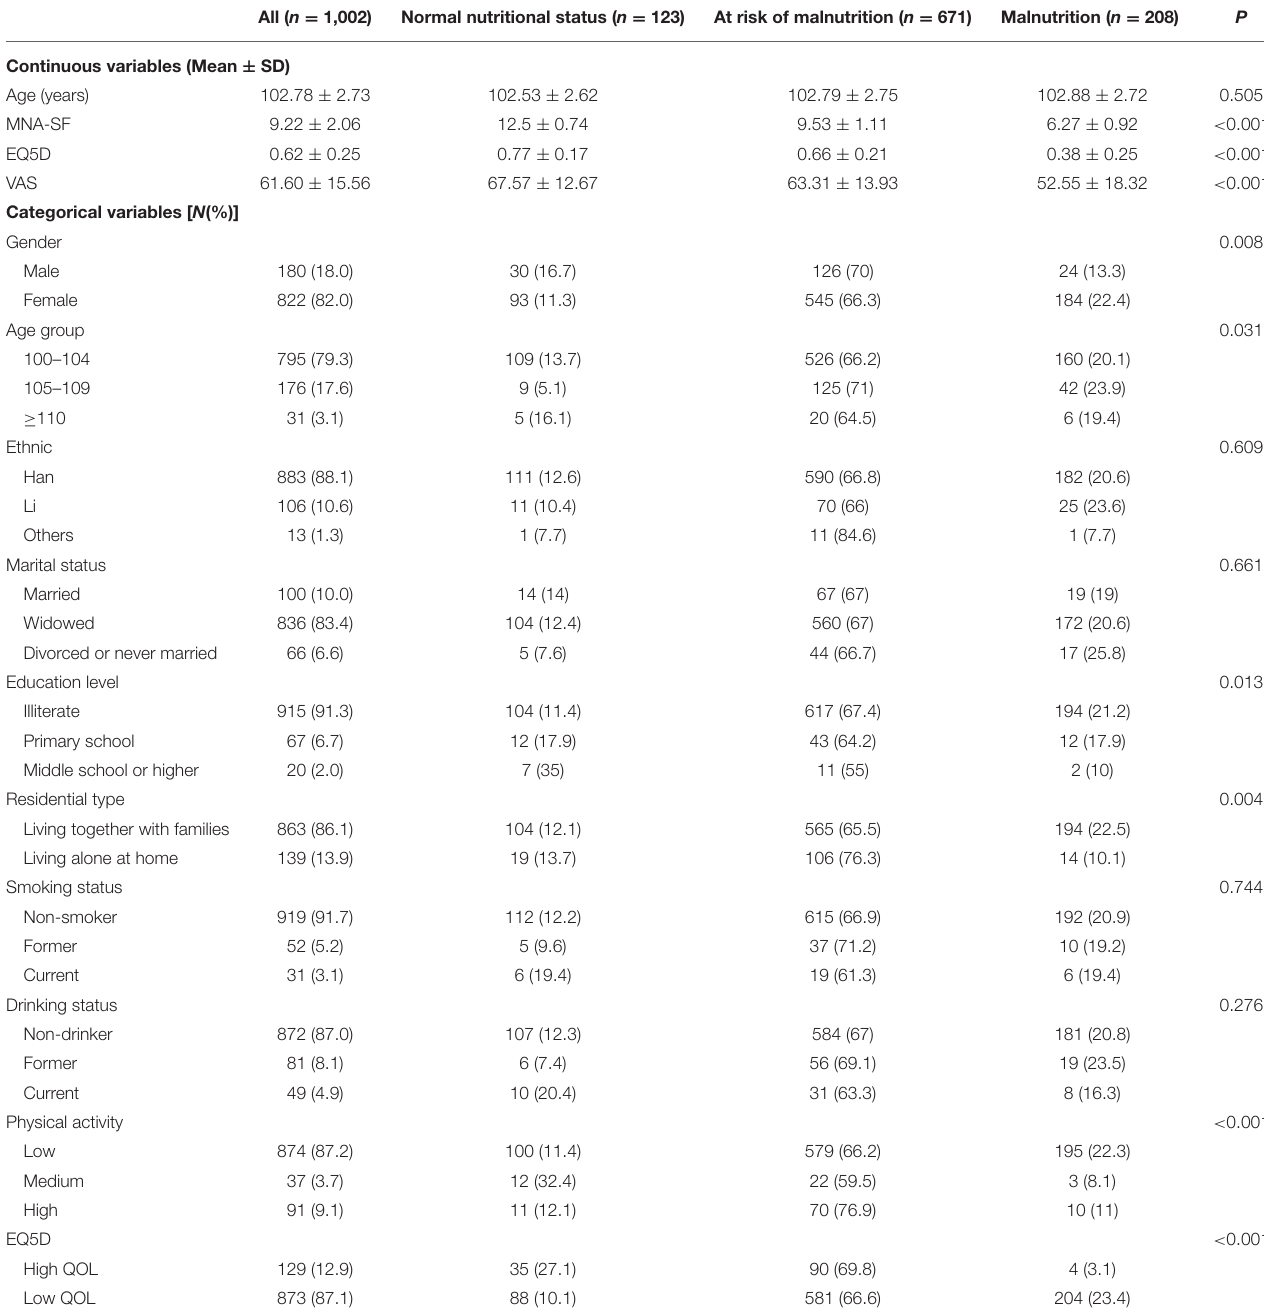
TABLE 1 | Sociodemographic characteristics of the CHCCS participants. All ( n = 1,002) Normal nutritional status ( n = 123) At risk of malnutrition ( n = 671) Malnutrition ( n = 208)